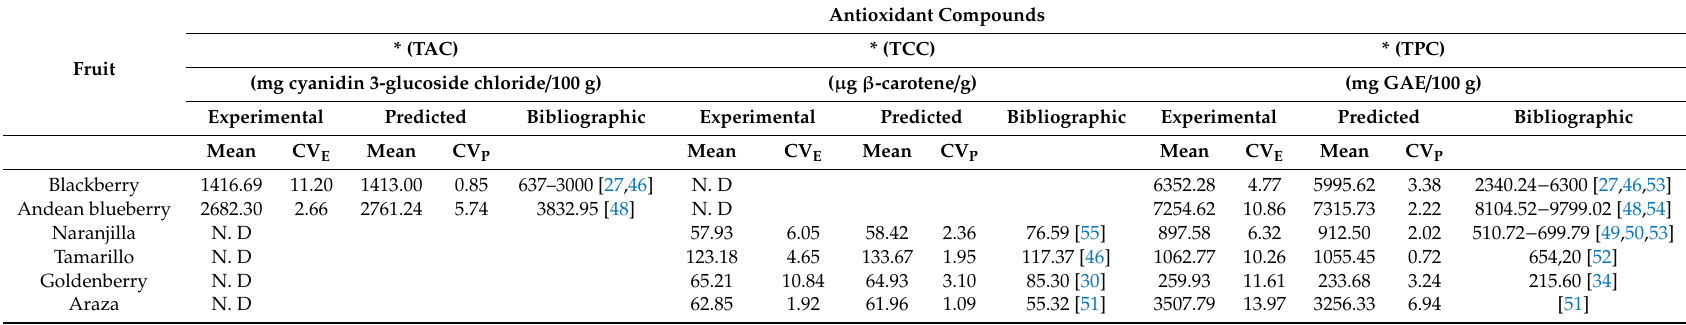
Table 5. Experimental and predicted values for total anthocyanin content (TAC), total carotenoid content (TCC) and total phenolic content (TPC) of six tropical and Andean fruits from Ecuador and a comparison with data reported in